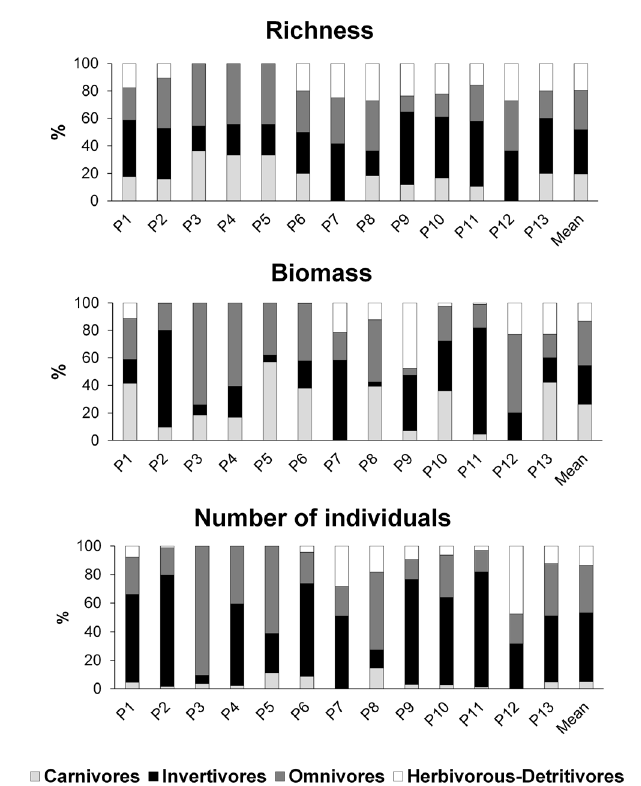
FIGURE 2 | Proportion of fish species richness, biomass, and number of individuals in each trophic group for each sampling point in the Paranapanema river basin, São Paulo state,